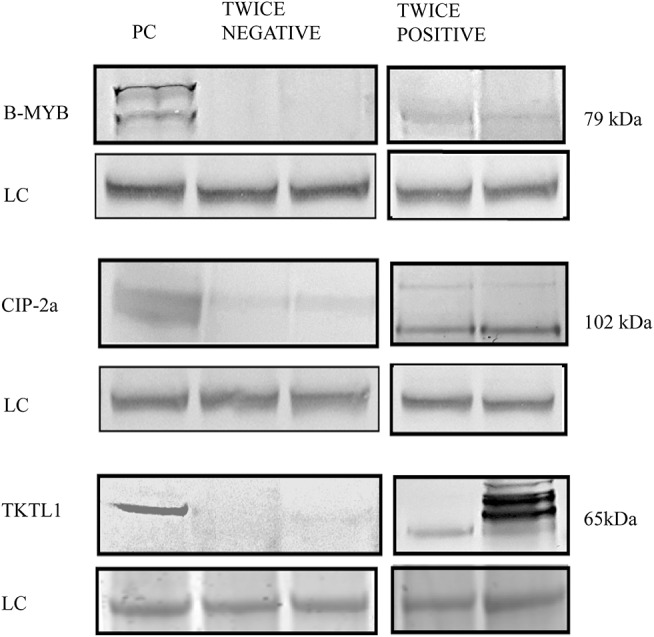
The different expression of putative biomarker proteins B-MYB, CIP-2a, and TKTL1 can be detected in Western immunoblots of cervical epithelium scraping leftovers from twice (LSIL/ASCUS and HR-HPV DNA)-positive and twice (HR-HPV DNA- and Pap-test)-negative patients. The typical immunoblots show also as positive controls (PC) the same proteins as expressed by pre-metastatic human cervical carcinoma C4-I cells. The loading control (LC) protein is β-actin. The samples were run on SDS-PAGE and blotted as detailed in the Materials and Methods section.